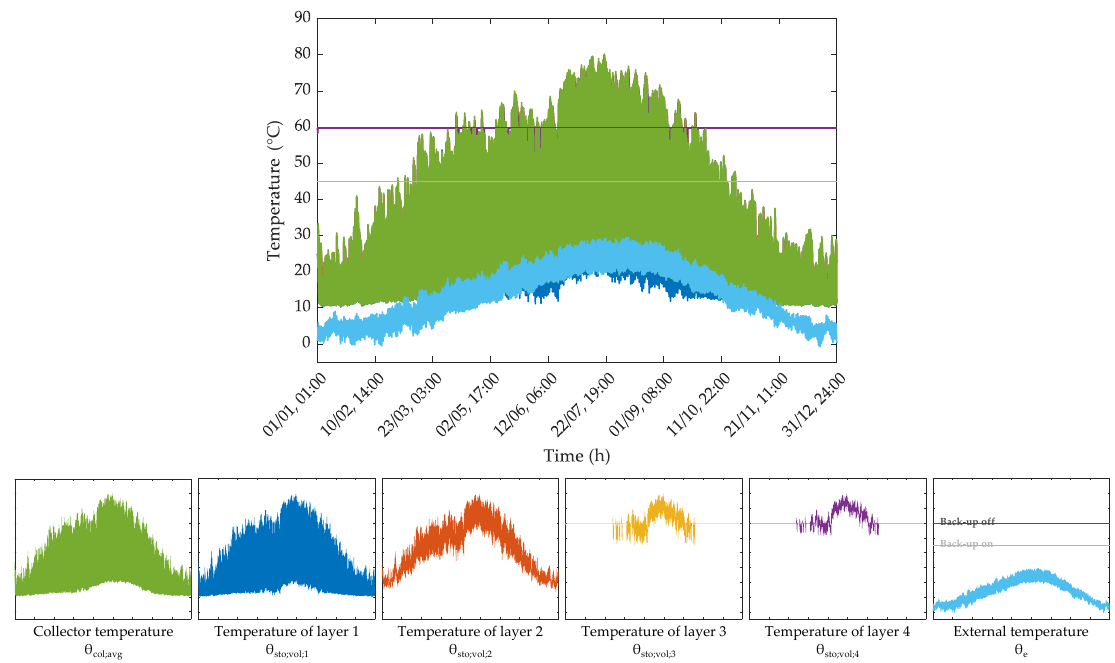
Figure 6. Results from standard simulation over a year. Time step 1 h. Solar pump running when Q sol;loop;out ≥ 3 · P sol;pmp · 10 − 3 · t ci . Storage layers numbered from bottom (1) to top